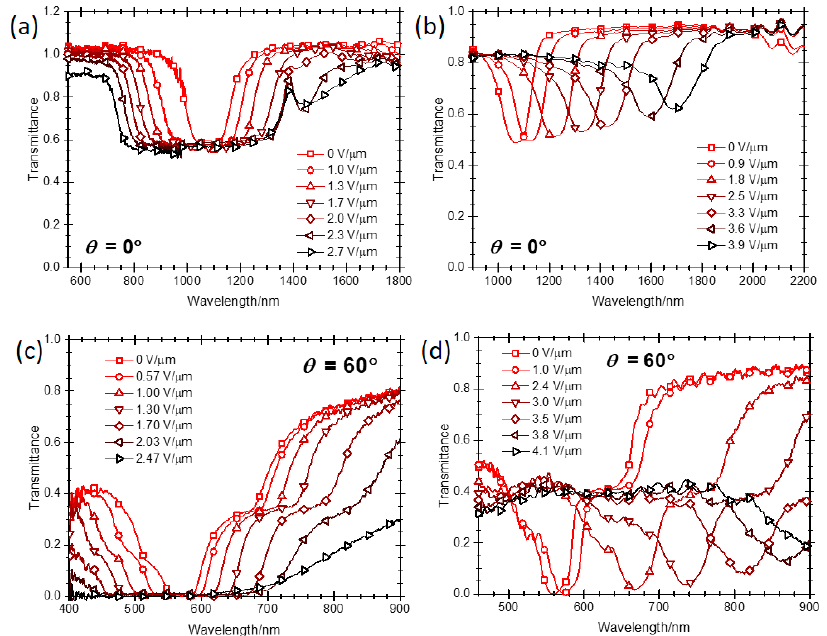
Figure 14. Variation of the optical properties of PSCLC with DC field: ( a , b ) transmission spectra at θ = 0° for unpolarized light and ( c , d ) transmission spectra at θ = 60° for unpolarized light. Adapted from ref. [91]. A 30-µm thick PSCLC was used for bandwidth broadening of the reflection band ( a , c ), and a PSCLC with a thickness of 15 µm was used for red tuning response ( b , d ).